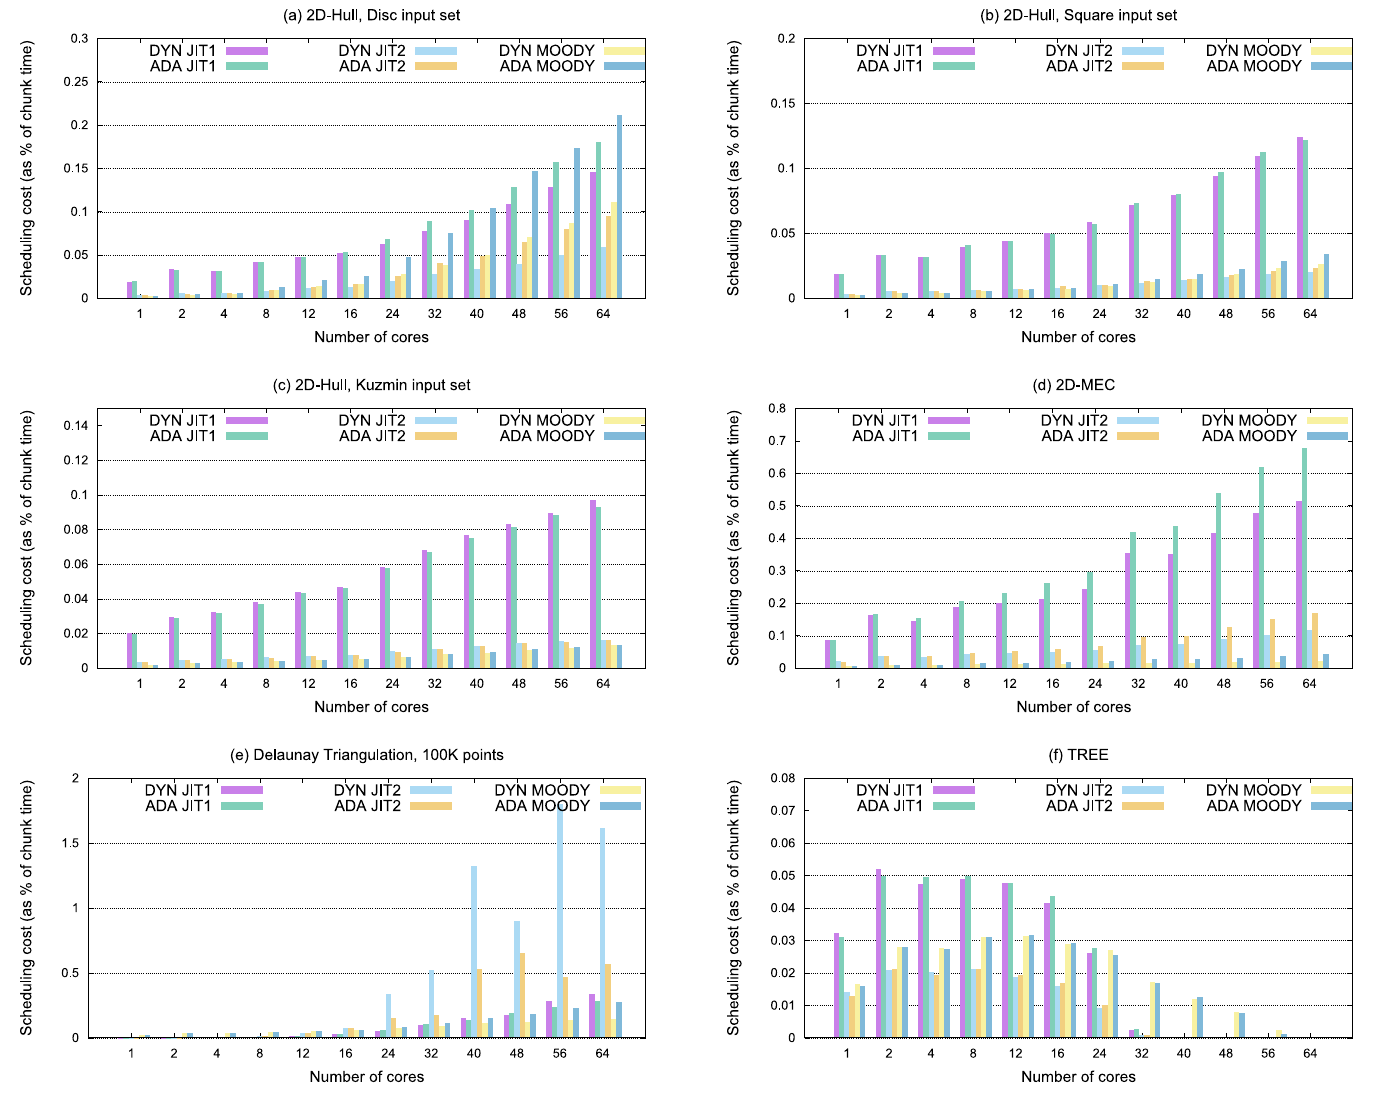
Fig 11. Time spent in the scheduling calculations for 2D-Hull with disc, square, and kuzmin input sets, and 2D-MEC, delaunay, and TREE.